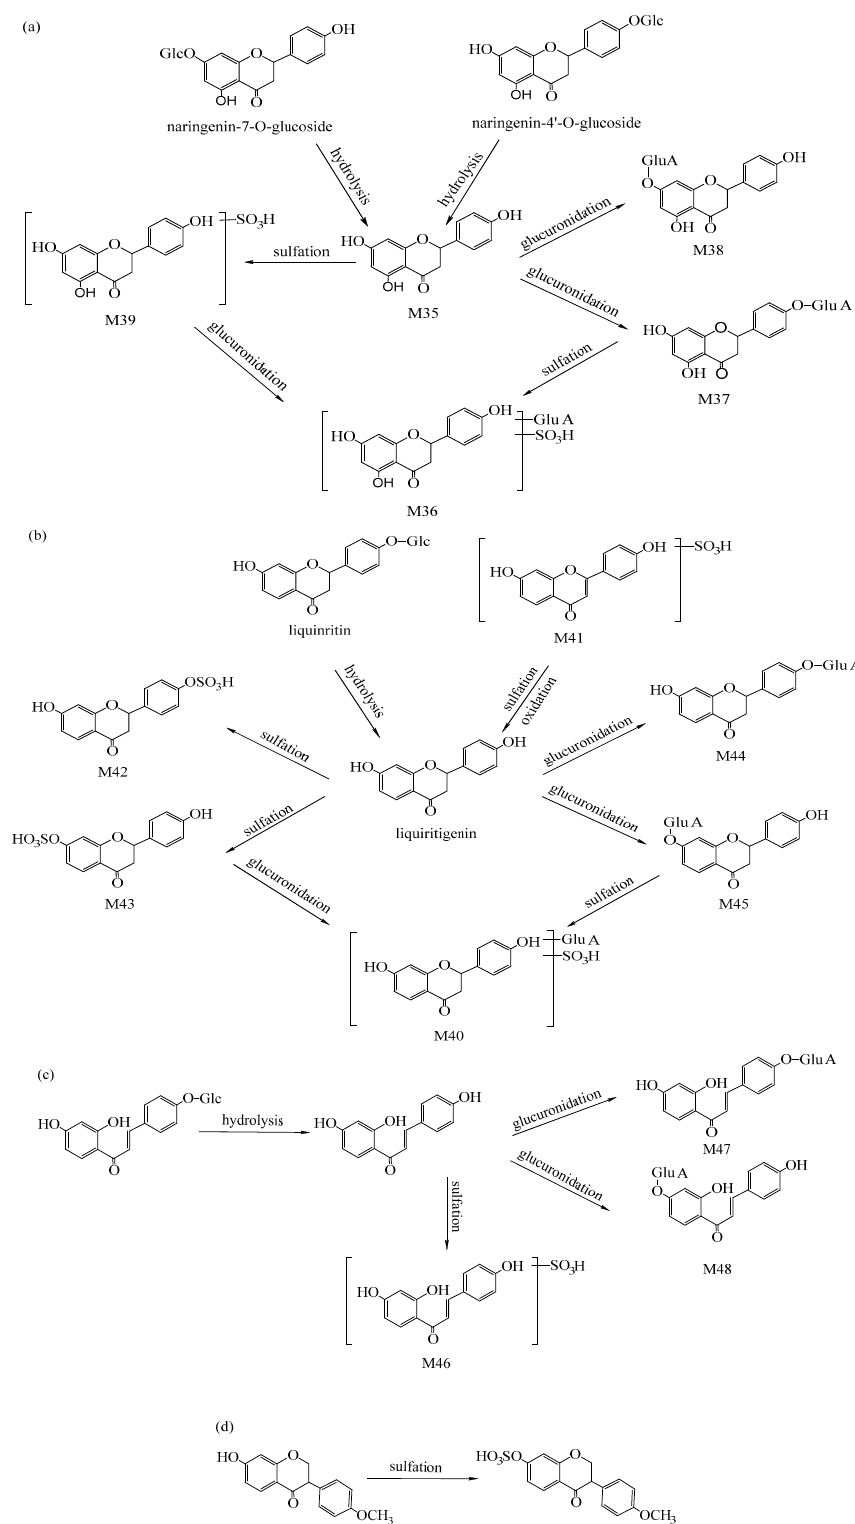
Figure 6. The potential metabolic profile of flavone-related metabolites. ( a ) Naringenin- O -glucoside- related metabolites; ( b ) Liquiritigenin-related metabolites; ( c ) Isoliquiritigenin-related metabolites; and ( d ) Formononetin-related metabolite.